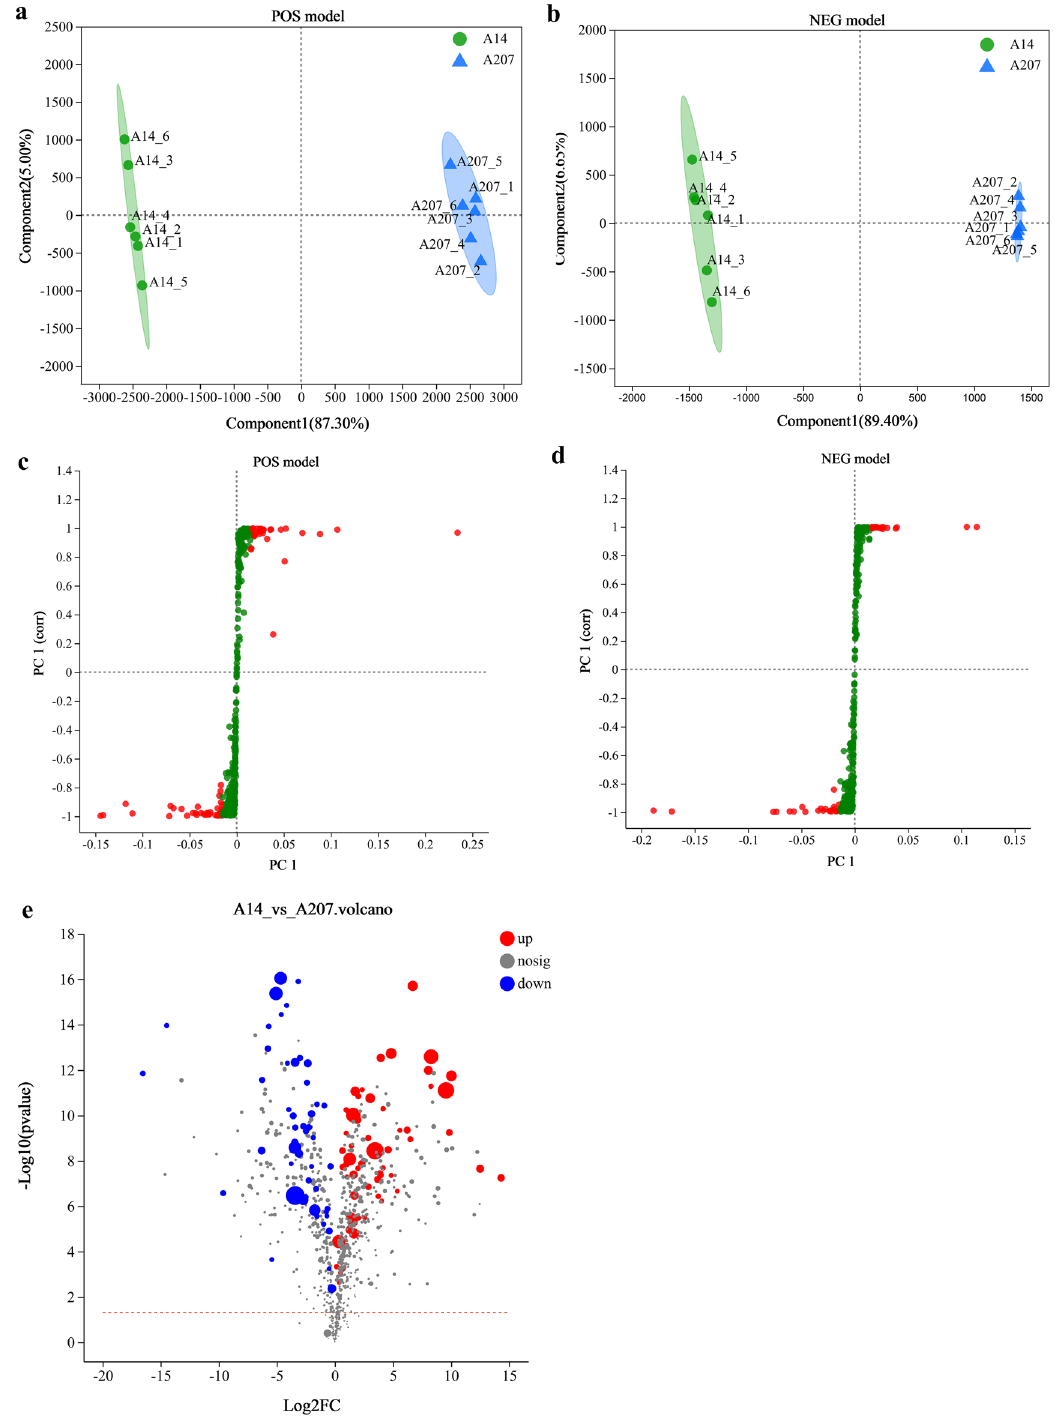
Figure 3. ( a , b ) PLS-DA scores plot derived from A14 and A207 each group in positive ion mode and negative ion mode. ( c , d ) S-plot based on OPLS-DA model (positive ion mode and negative ion mode). ( e ) Volcano map of differential metabolites between A14 group and A207 group. Each point in the figure represents a